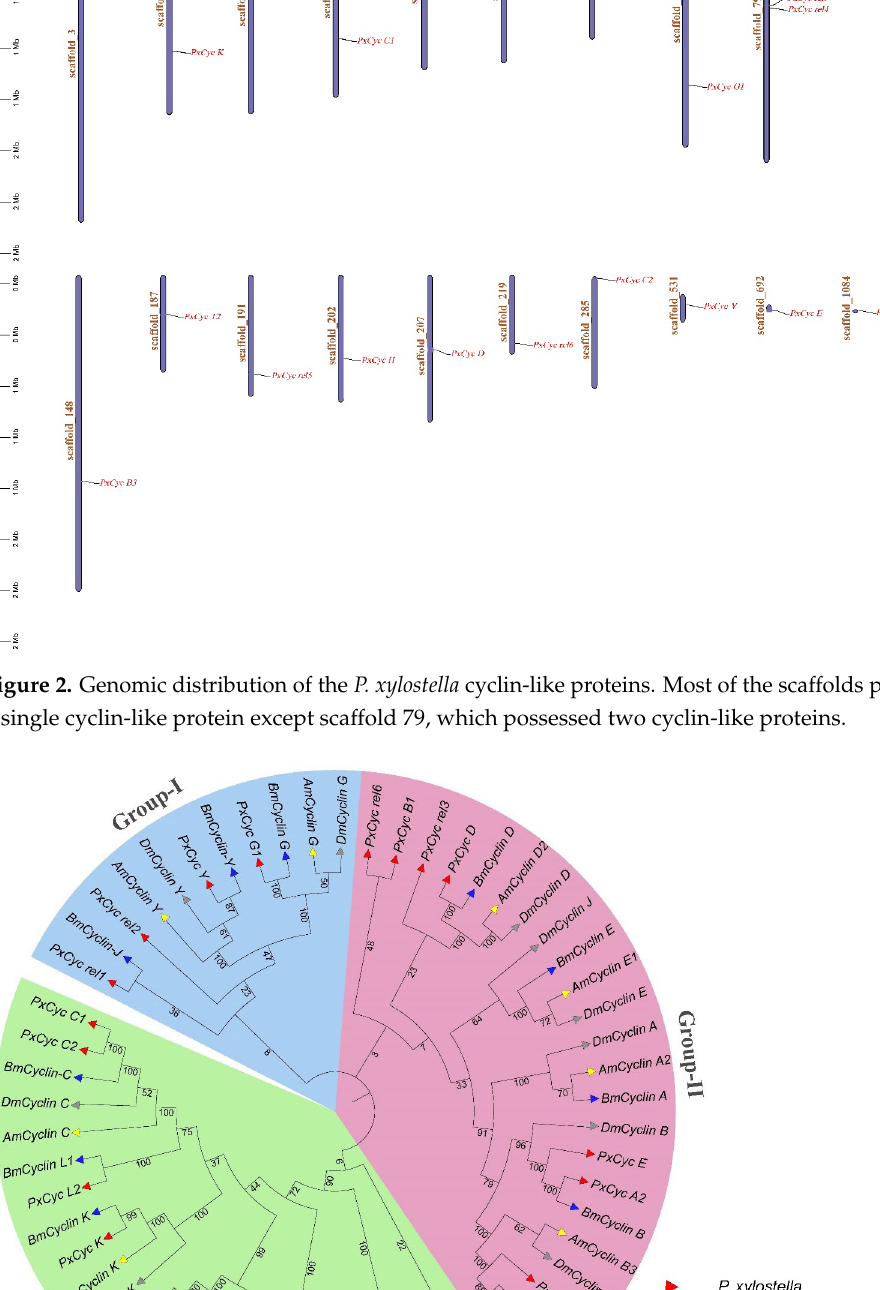
Figure 3. Phylogenetic relationships of the cyclin-like proteins of P. xylostella and three other insect species ( B. mori, D. melanogaster, and A. melefera ). The phylogenetic tree is classified into three groups. Different groups are highlighted with different colors. Group I, Group II, and Group III are highlighted with pink, light blue, and green colors, respectively.